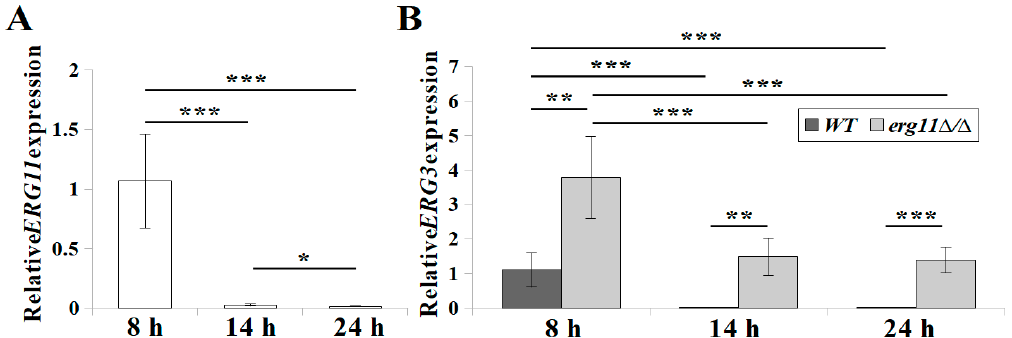
Figure 2. (A ) Relative ERG11 gene expression in C. albicans WT (CAF2-1) strain during growth (8, 14, and 24 h), not detected in the KS028 ( erg11 ∆ / ∆ ) strain; ( B ) Relative ERG3 gene expression in C. albicans WT and erg11 ∆ / ∆ strains during growth (8, 14, and 24 h). Gene expression levels are reported as means of 2 − ∆∆ CT values ( n = 6) ± SD; normalised to 1 after 8 h WT gene expression. Statistical analysis was performed by comparing expression during growth between C. albicans WT and erg11 ∆ / ∆ strains (*, p < 0.05; **, p < 0.01; ***, p < 0.001).